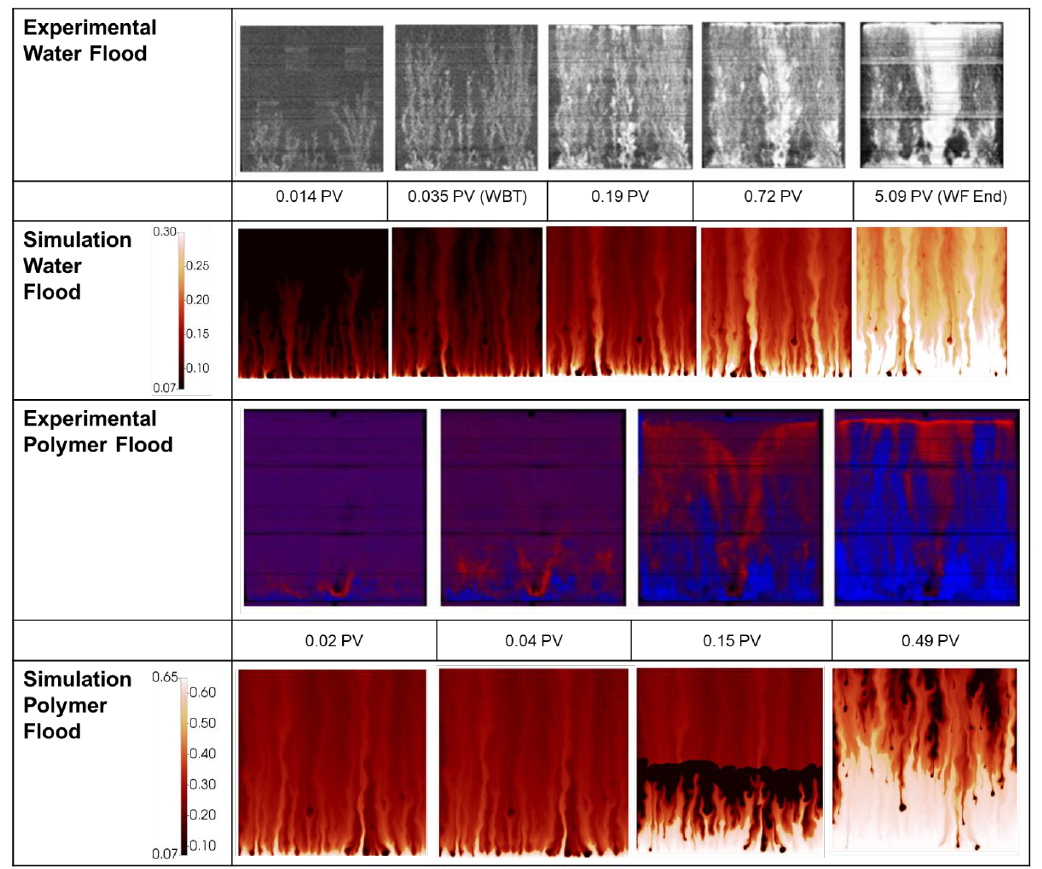
Figure 8. Experimental vs. simulated finger patterns during displacement of 7000 mPa.s oil.